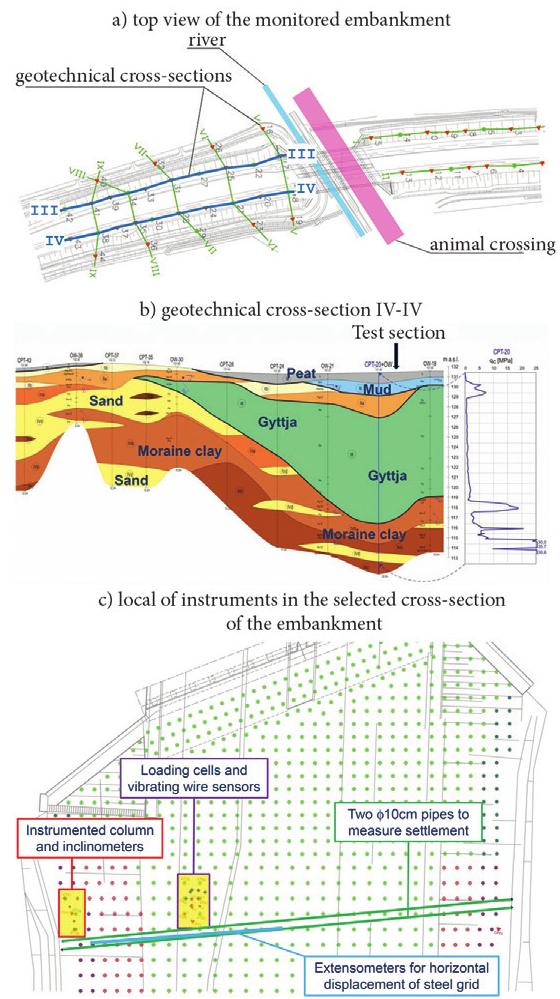
Fig. 1. Location of the monitored embankment